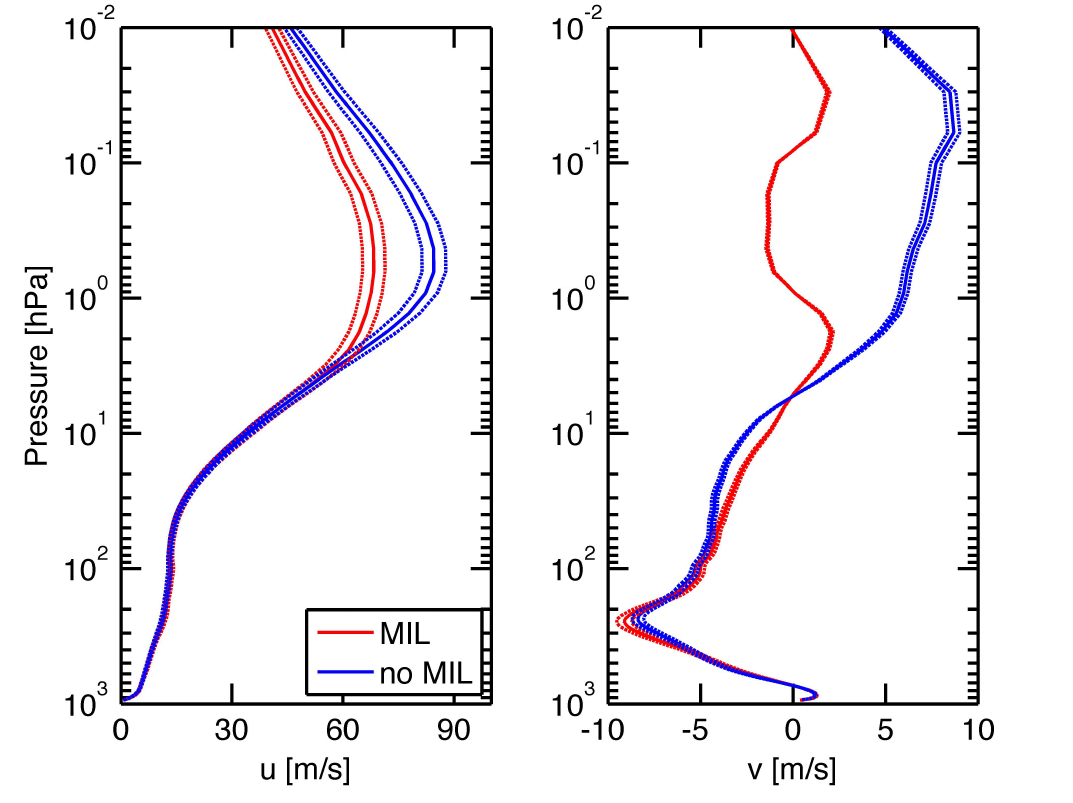
Figure 5. ECMWF (European Centre for Medium-range Weather Forecast) analysis at Bern: Eastward wind u and northward wind v during an MIL (red) and during “no MIL” (blue). Dashed lines show the error of the